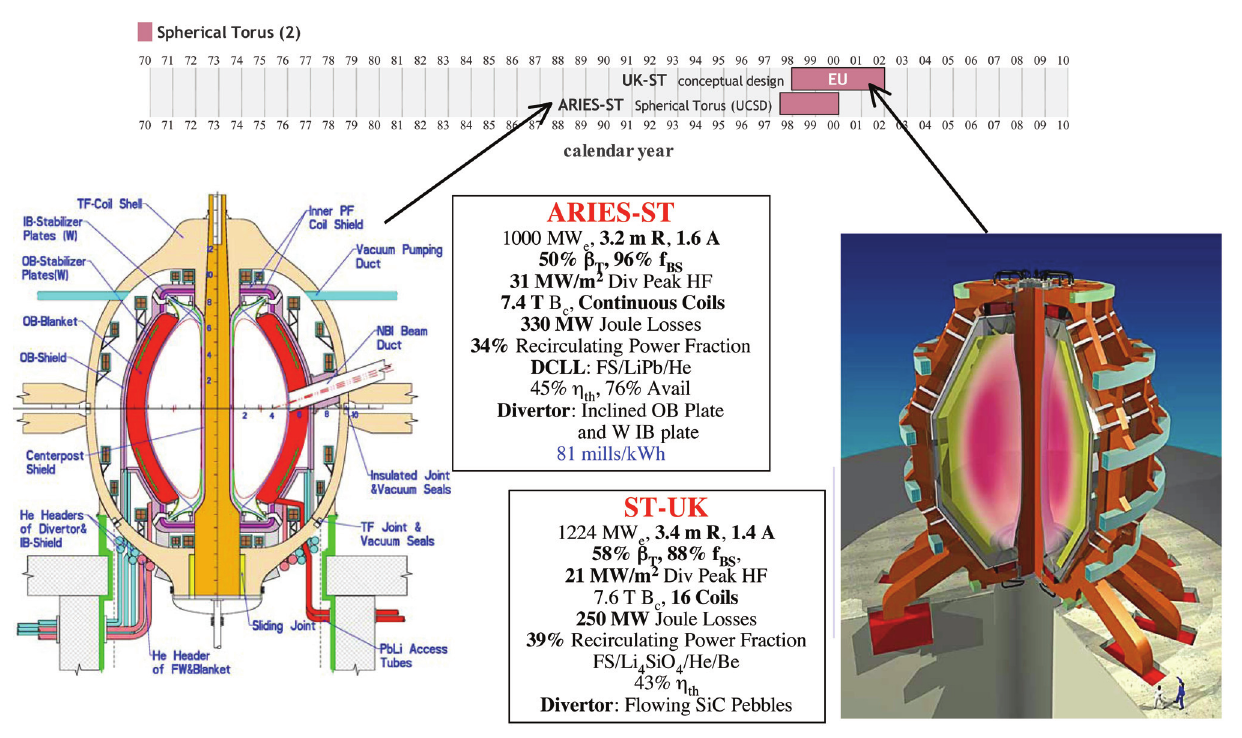
Figure 7. Timeline and main features of spherical torus power plant studies.